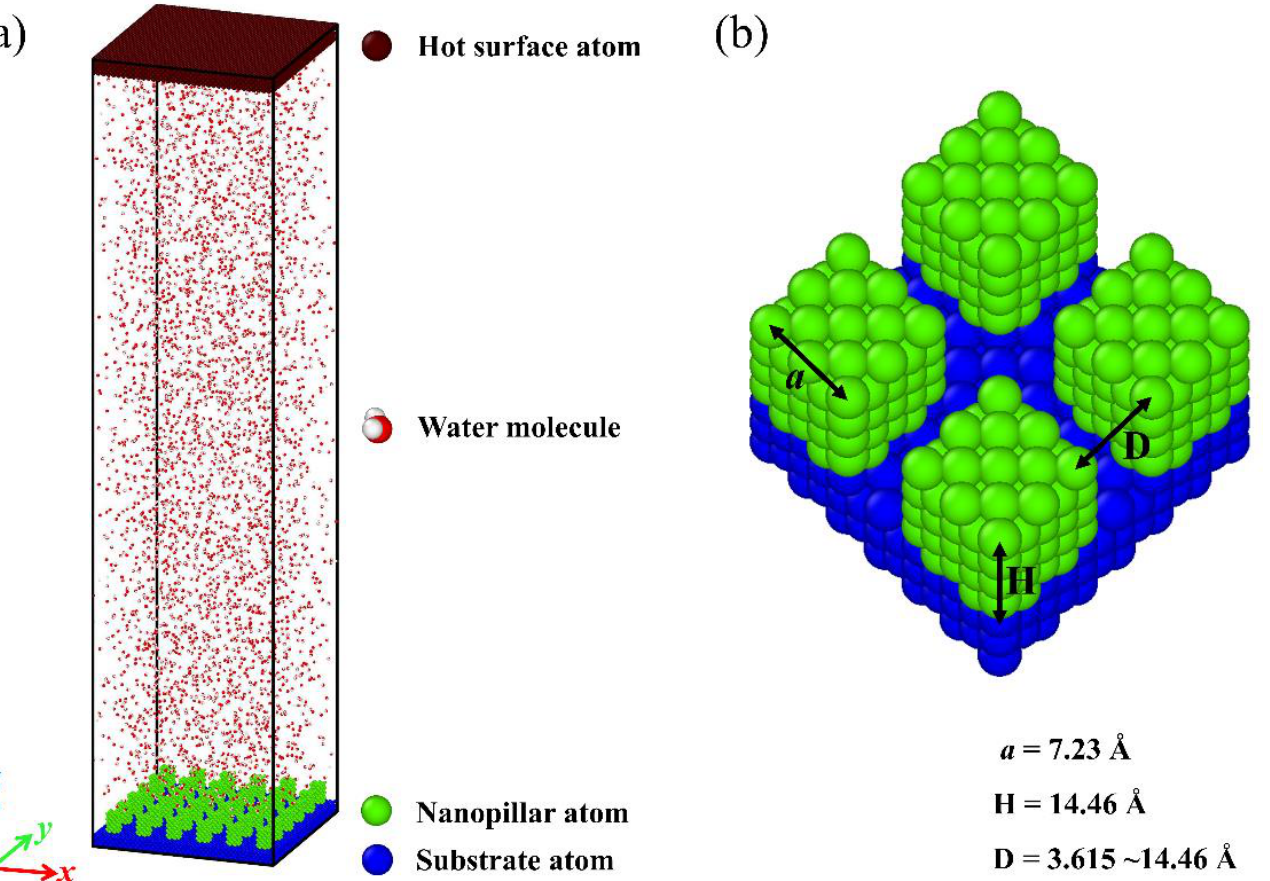
Figure 1. ( a ) An overview of the simulation domain. ( b ) Schematic diagram for parameters of nanopillar surface.